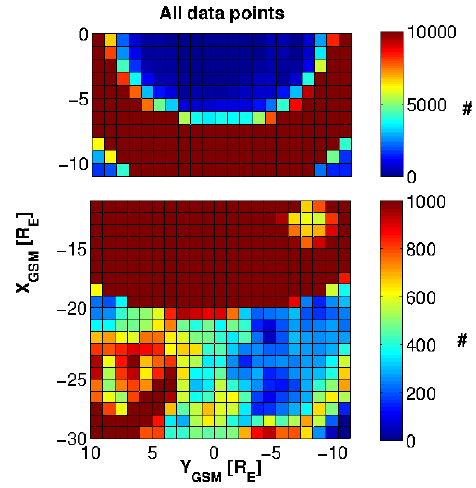
Figure 5. Number of all 1min averaged data points in 2008–2011.